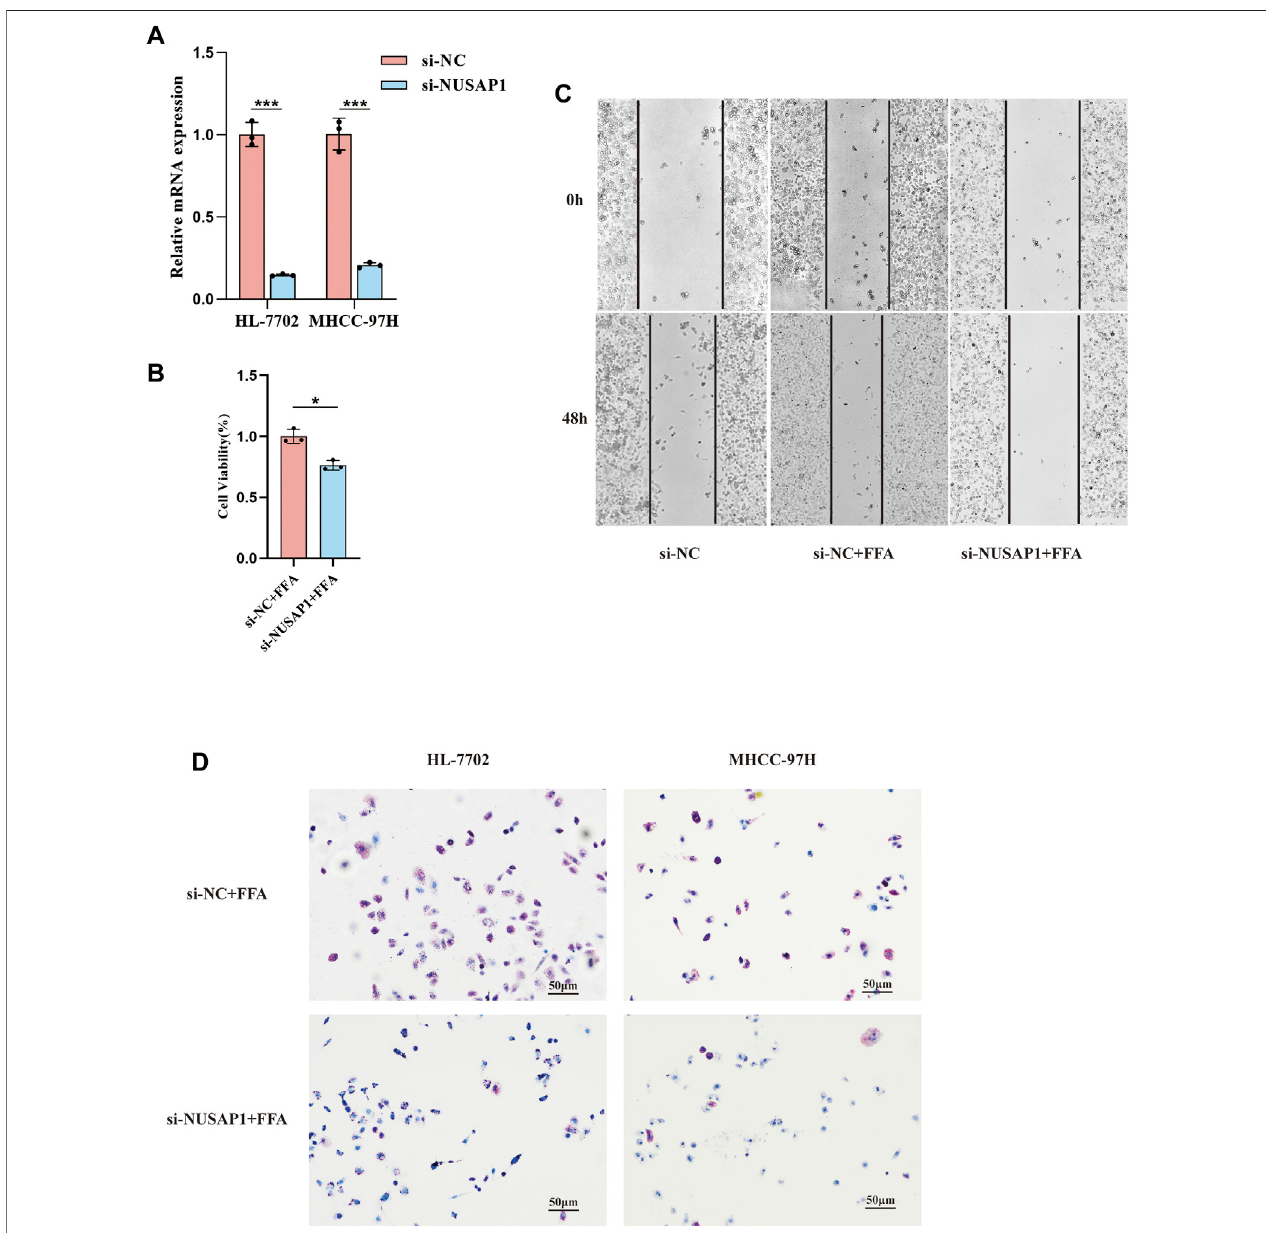
FIGURE 7 | Validation of the function of NUSAP1 via the silencing assay. (A) Con fi rmation of NUSAP1 silence ef fi ciency in HL-7702 and MHCC-97H cell lines by RT-PCR. (B) CCK-8 analysis of cell growth in MHCC97H ( n = 3). (C) Wound-healing assays for MHCC-97H. (D) Oil Red O staining of the NUSAP1 silence in HL-7702 and MHCC-97H cell treated with FFA for 24 h, 100Xfor the images. The data were presented as mean ± SEM, n = 3 each group. * p < 0.05, *** p < 0.001.